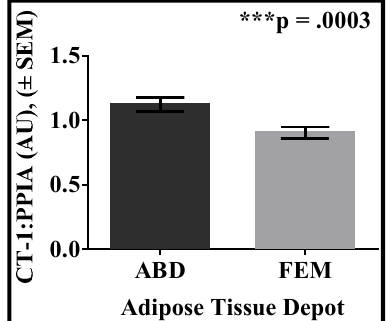
Figure 1. CT-1 expression is higher in the scABD than the scFEM AT depot in women with obesity. Subcutaneous abdominal (scABD) and femoral (scFEM) adipose tissue depots were collected from women with obesity ( N = 22). RNA was extracted, and ~200 ng was processed for cardiotrophin (CT)-1 mRNA analysis. Samples were run in triplicate, and expression levels were normalized to cyclophilin